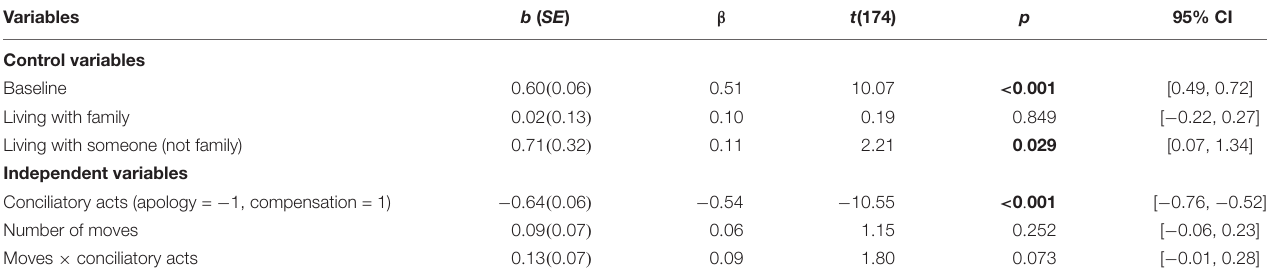
TABLE 1 | The results of regression analysis (Study